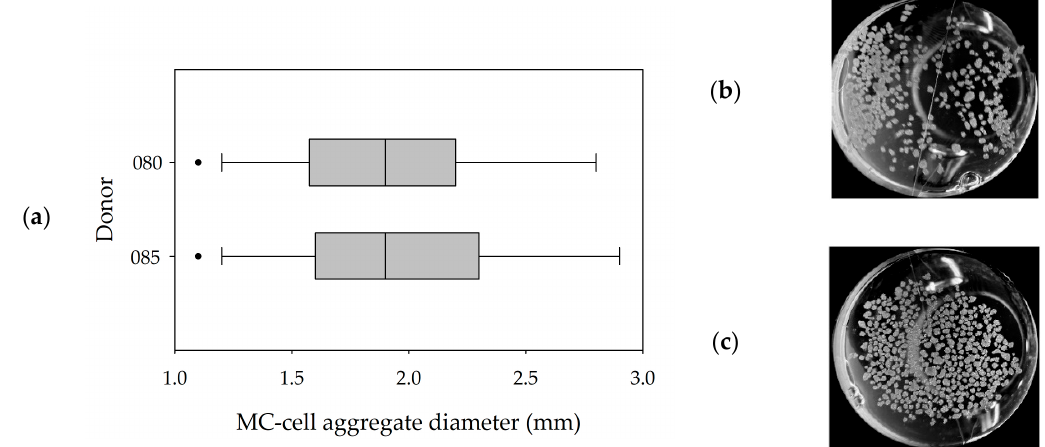
Figure 6. MC-cell-aggregate diameter distributions ( a ) and photographic images ( b , c ) of MC-cell aggregates at the end of the cultivations (day 9). Donor 080 ( b ) and 085 ( c ).